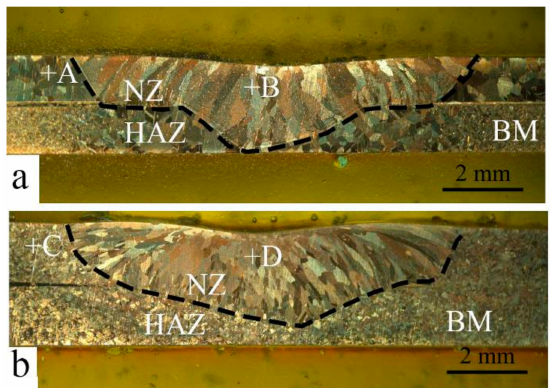
Figure 6. The cross-section macrostructure of a GTA spot-welded joint ( a ) without USV; and ( b ) with 6 s USV.